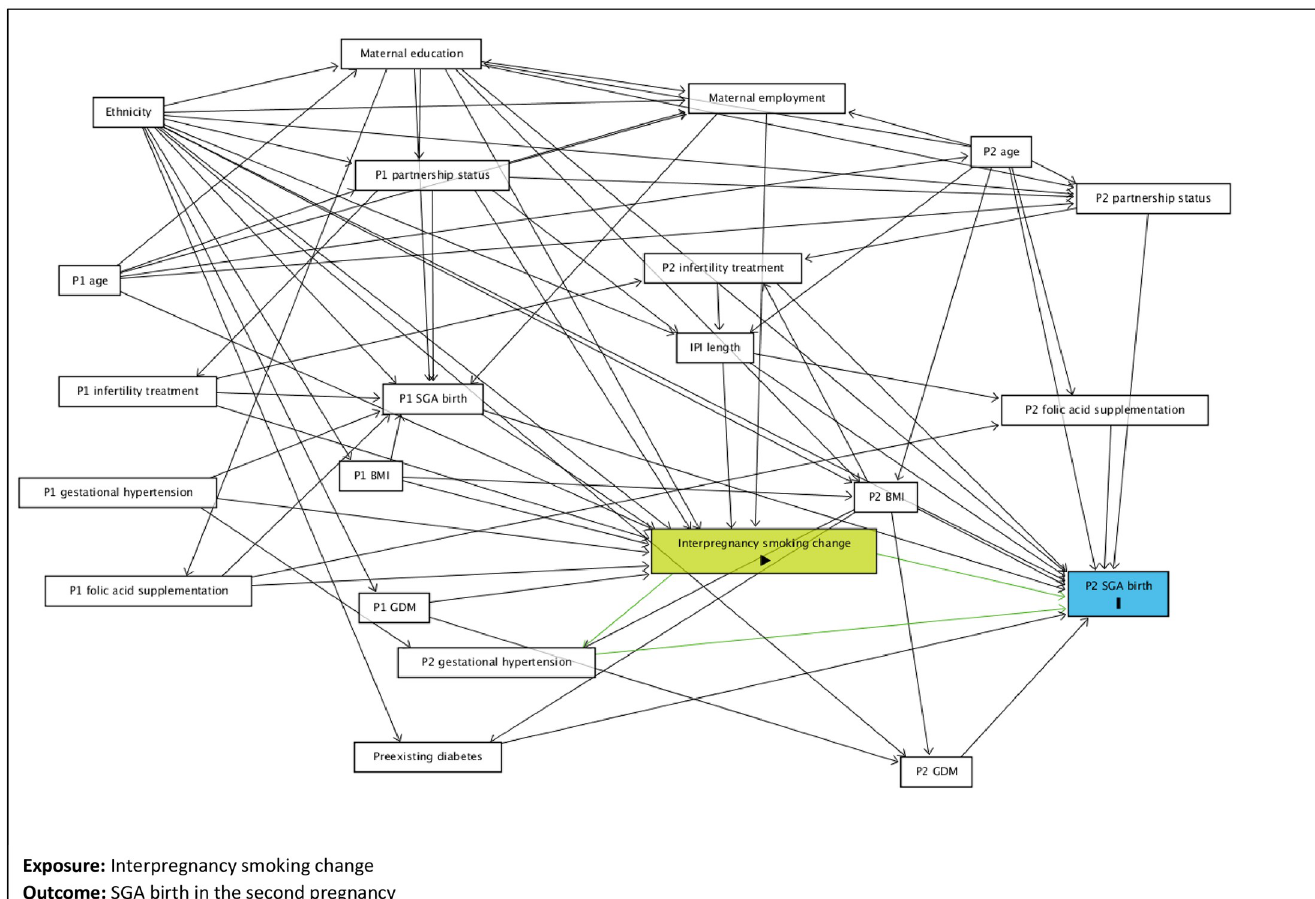
Fig 2. Directed acyclic graph showing the exposure (interpregnancy smoking change) and the outcome (being born small for gestational age (SGA)).